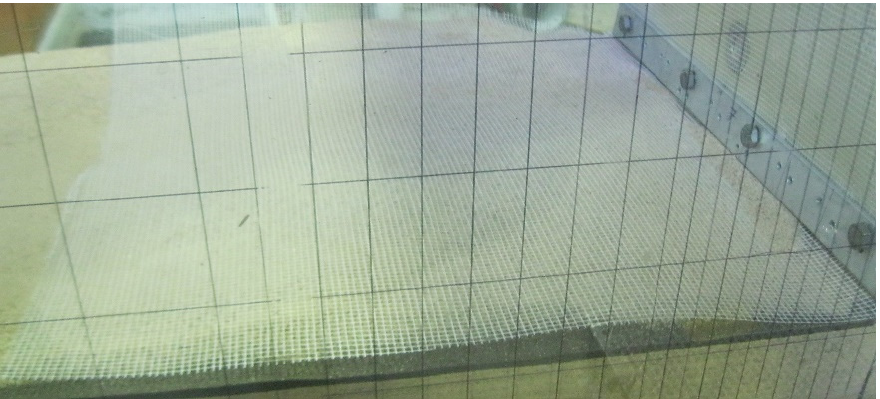
Figure 5. Noncommercial PolyEthylene grid selected for the modeling.